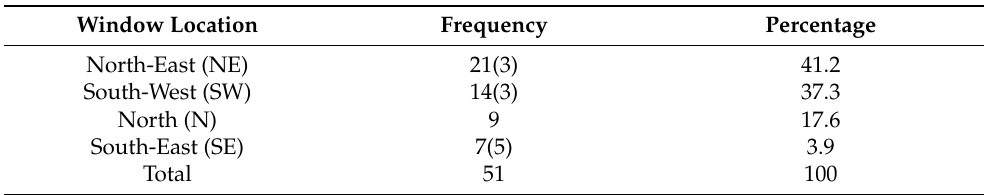
Table 1. Number of rooms based on the location of the windows; rooms with two windows are shown within parenthesis.